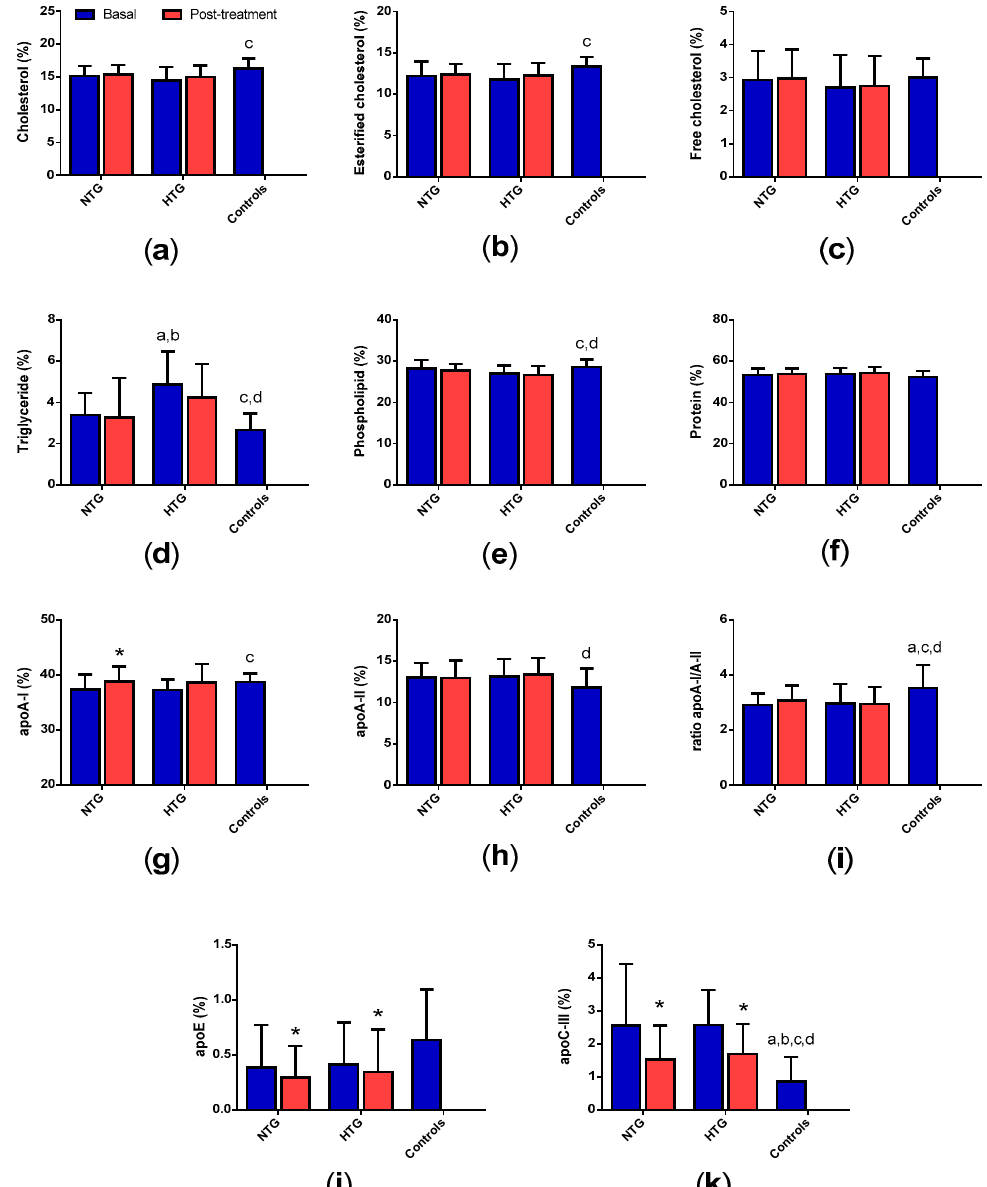
Figure 6. HDL composition. Data indicate the relative proportion of each component of the HDL mass, except the ratio apoA-I / apoA-II, and are expressed as mean ± SD. ( a ) total cholesterol, ( b ) esterified cholesterol, ( c ) free cholesterol, ( d ) triglycerides, ( e ) phospholipids, ( f ) total protein, ( g ) apoA-I, ( h ) apoA-II, ( i ) ratio apoA-I / apoA-II, ( j ) apoE, ( k ) apoC-III. * p < 0.05 vs. basal samples. a p < 0.05 vs. basal NTG. b p < 0.05 vs. NTG post-treatment. c p < 0.05 vs. basal HTG. d p < 0.05 vs. HTG post- treatment.